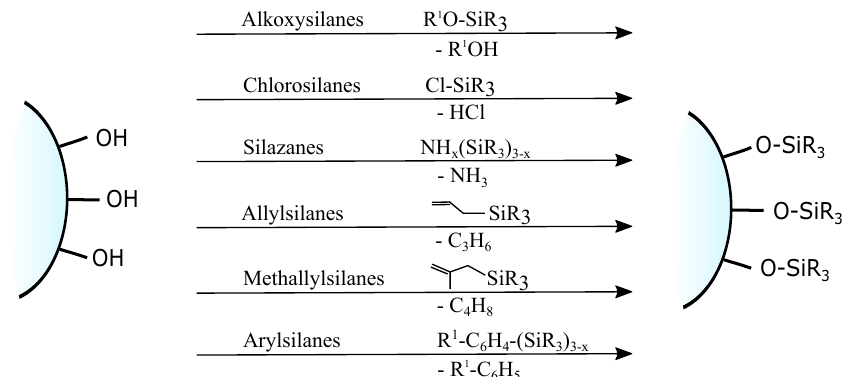
Figure 12. Grafting of silanol groups with various